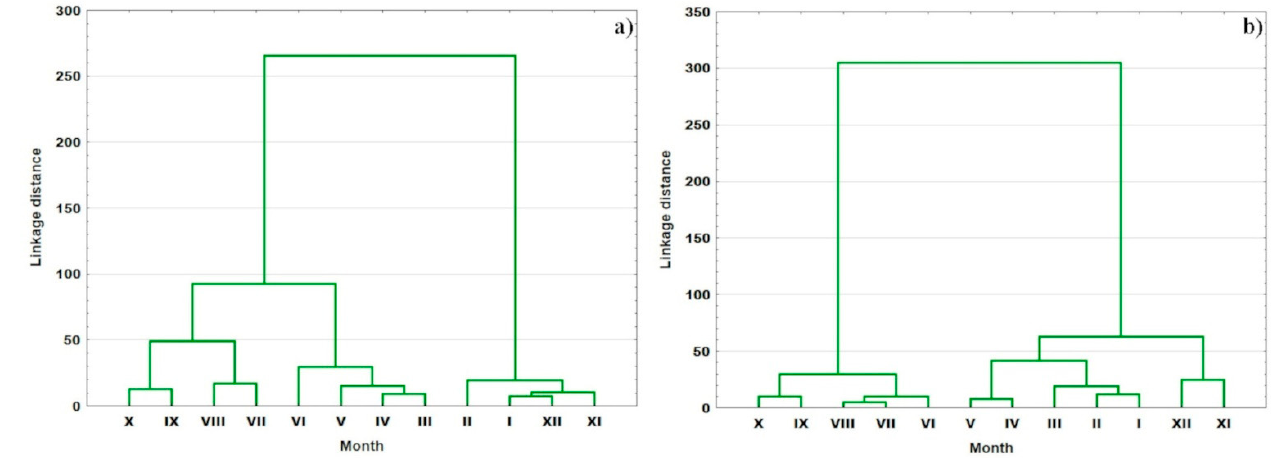
Figure 6. Dendrograms showing the months clustering in ( a ) 2018 and ( b ) 2019.